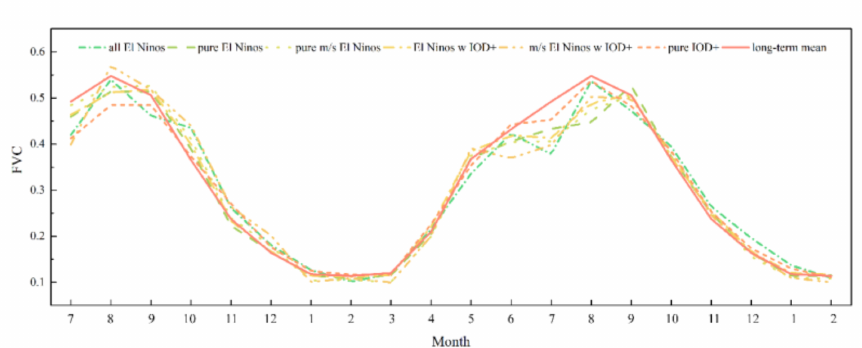
Figure 13. Average value of FVC in the study site during different EI Nino/IOD+ stages from 2000 to 2019.